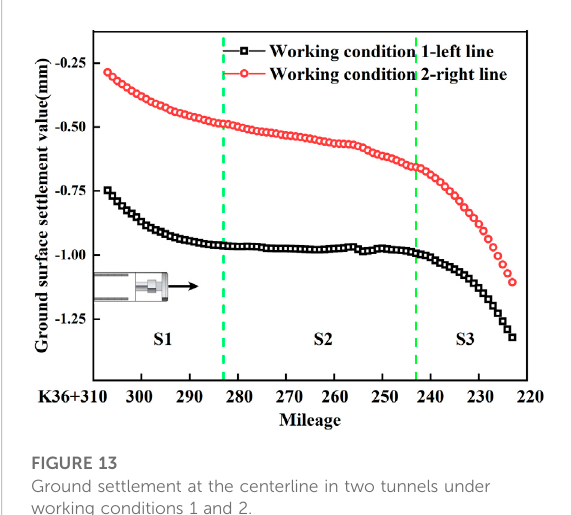
FIGURE 11 Ground settlement of the cross-section at K36 + 250 under working conditions 1 and 2.